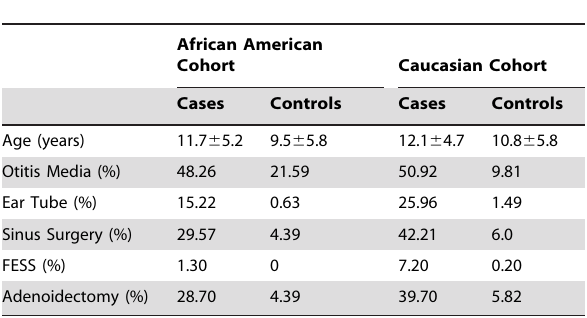
Table 1. Demographics and clinical features of study groups.